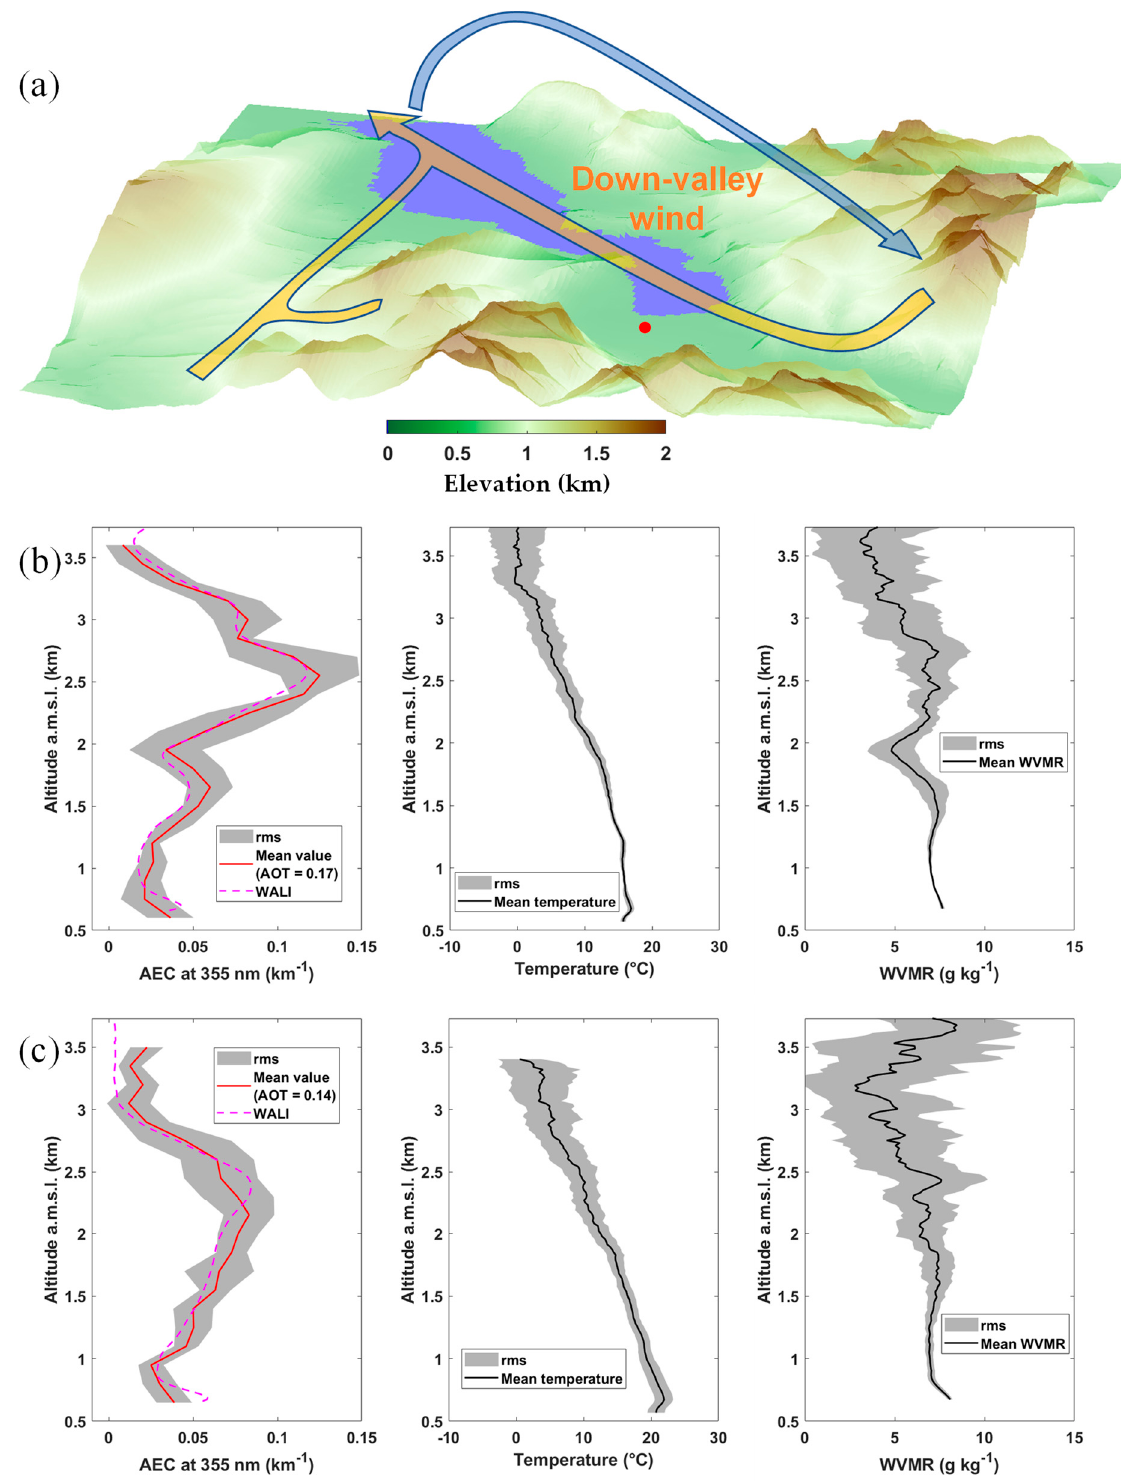
Figure 6. ( a ) Schematic representing the circulation patterns in the Annecy valley associated with the vertical lidar profiles shown below, in ( b , c ). Vertical profiles of the aerosol extinction coefficient (AEC), temperature, and water vapor mixing ratio (WVMR) during ultralight flights on ( b ) 18 June 2019, 08:30–0945 LT and ( c ) 18 June 2019, 11:00–12:30 LT. The ground-based lidar location is indicated by a red dot.